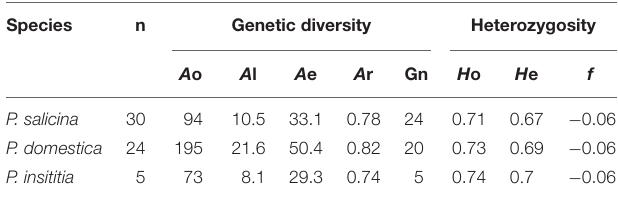
TABLE 7 | Diversity parameters of tested Prunus species based on SSR loci. Species n Genetic diversity